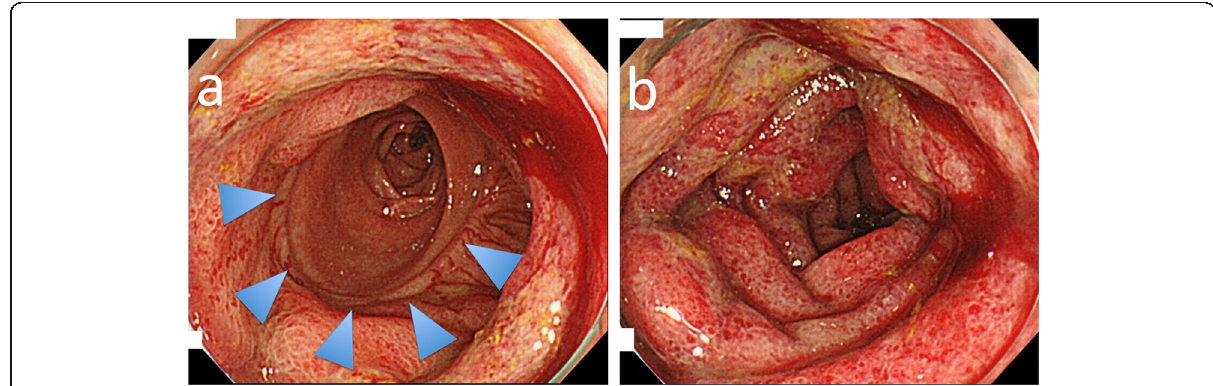
Fig. 1 a The oral side of the anastomosis was normal colon mucosa. The arrow indicates anastomosis. b The anal side of anastomosis was